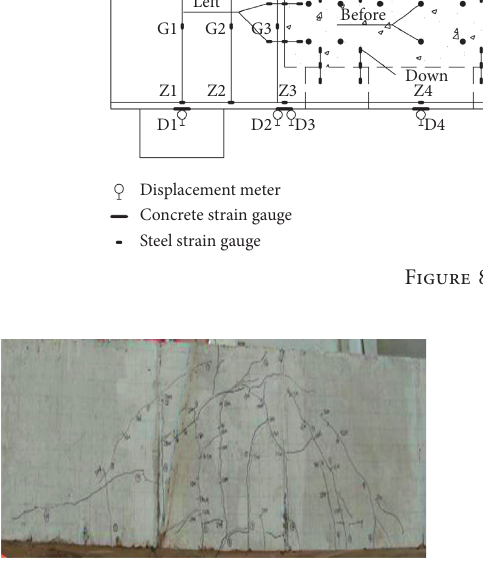
Figure 9: Crack diagram of north side.